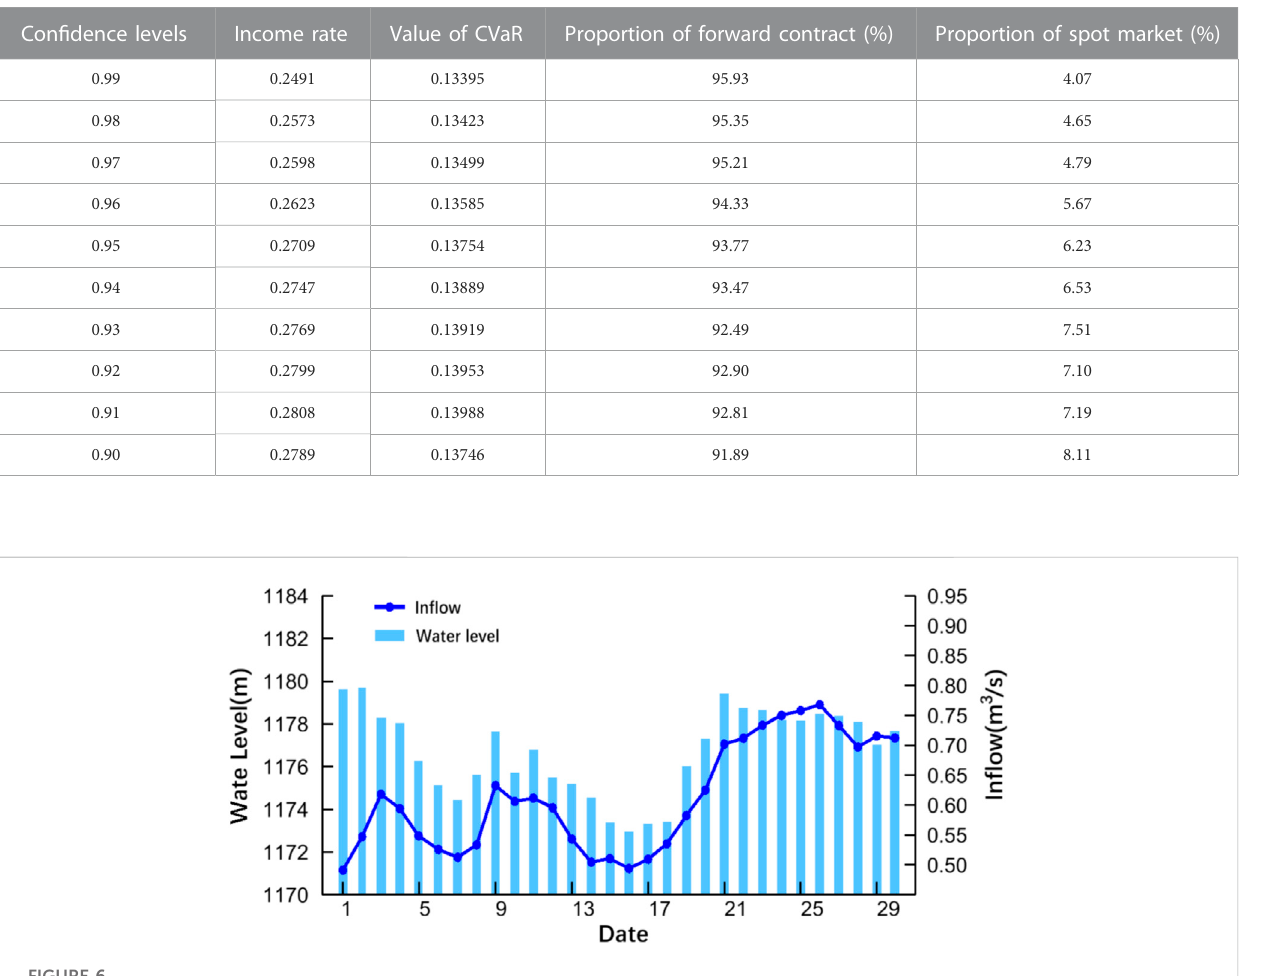
FIGURE 6 Result of optimized water level curve and in fl ow process.